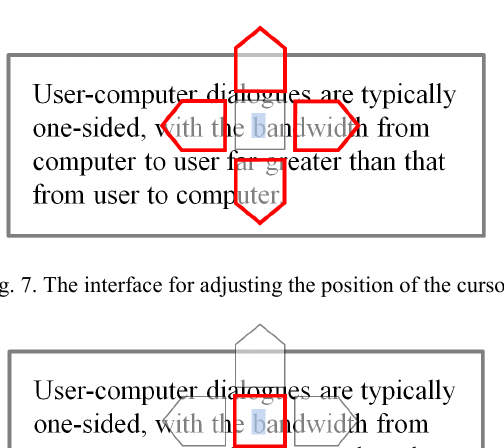
Fig. 6. Involuntary eye movement during eye fixation